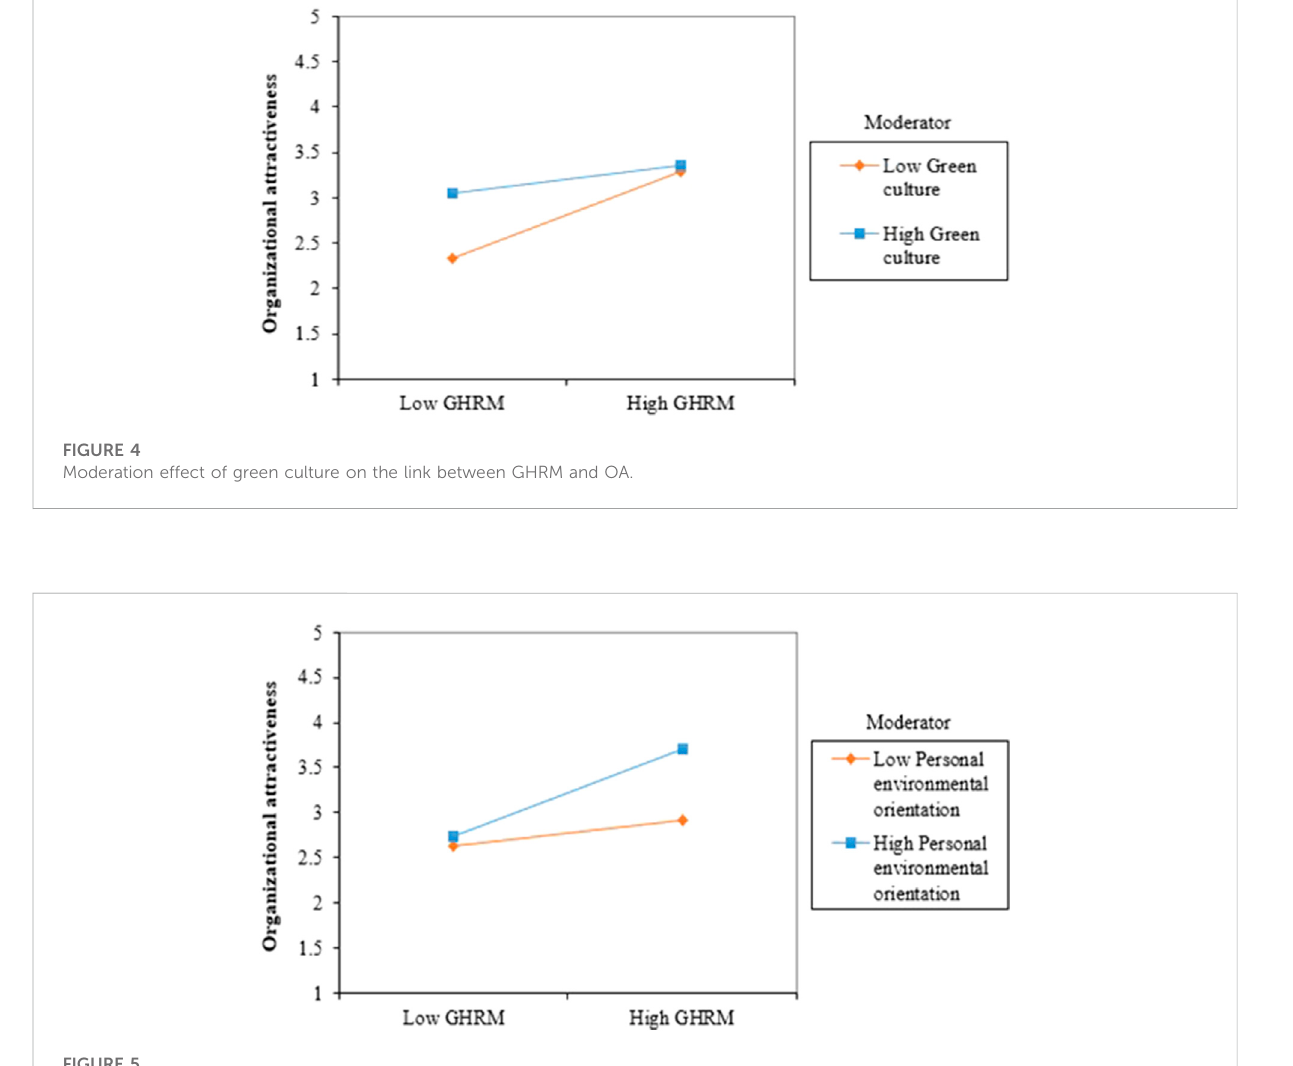
FIGURE 5 Moderation effect of personal environmental orientation on the link between GHRM and